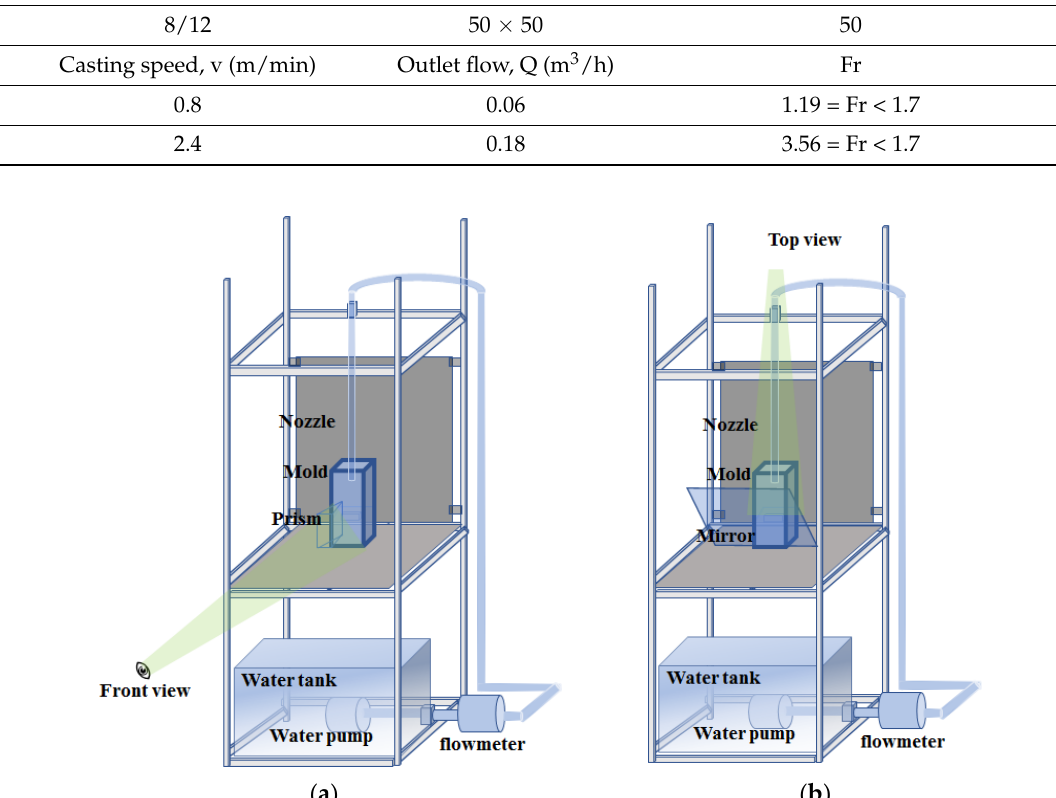
Figure 3. Experimental setting. ( a ) Front view and side view. ( b ) Top view and front